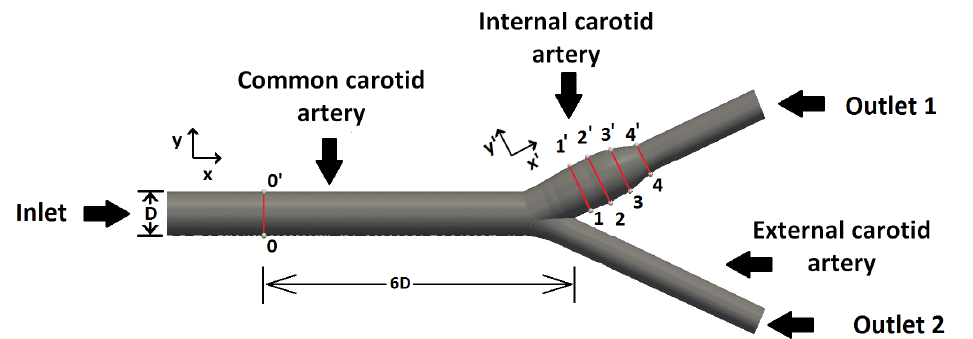
Figure 1. Side view of the computational geometry of carotid and indication of measurement locations (red